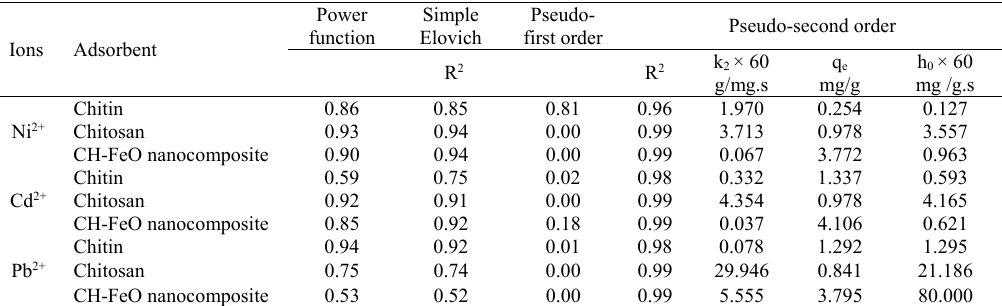
Table 3: The R 2 values in study adsorption kinetic